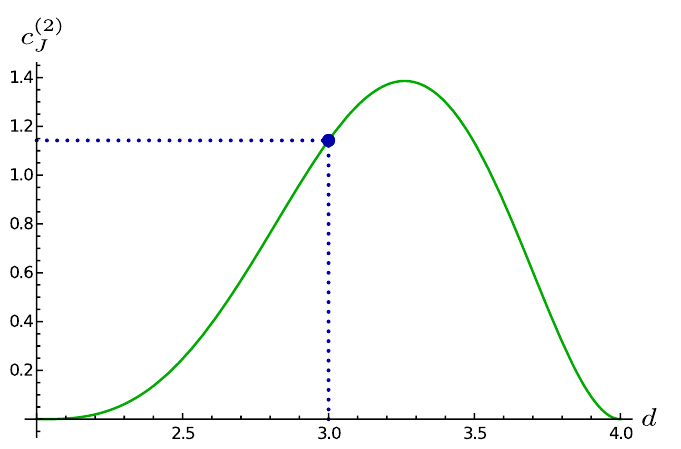
in (3.54) to the ratio of the global J